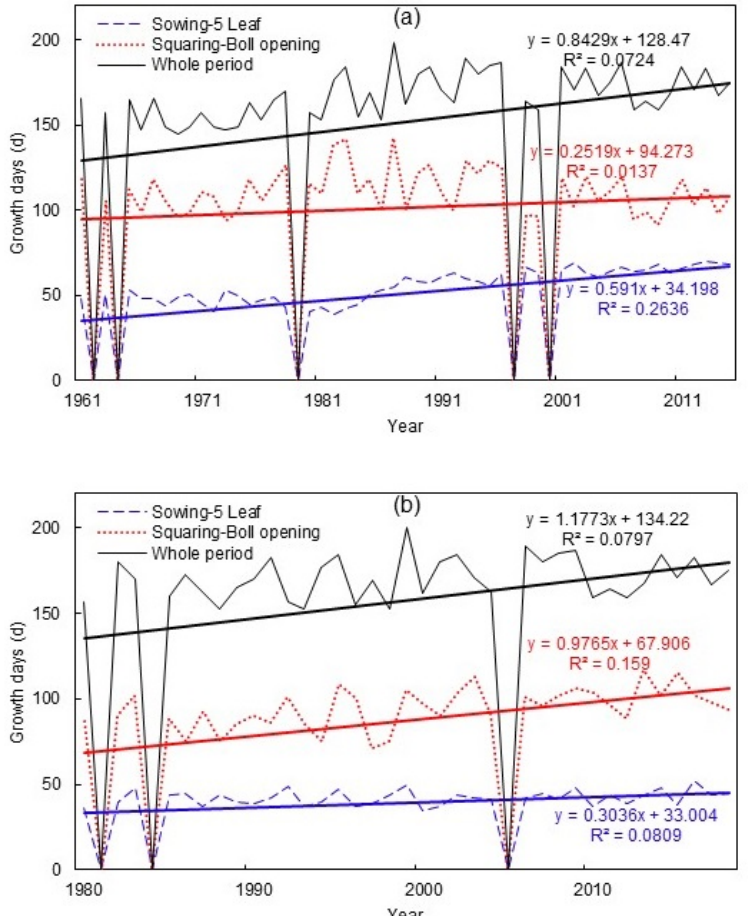
Figure 3. Simulated rends of ( a ) three simulated phenological growth stages of cotton from 1961–2015 in Punjab. Intercept values mentioned in the figure apply to the time of (growth days) sowing-five leaf stage, squaring to boll opening, and stop maturity in the starting year 1961. The variable x in the regression equations is calculated as x = year − 1961 (where p = 0.52); ( b ) three simulated phenological growth stages of cotton from 1980–2018 in Xinjiang. Intercept values mentioned in the figure apply to the time of (growth days) sowing-five leaf stage, squaring to boll opening, and stop maturity in the starting year 1981. The variable x in the regression equations is calculated as x = year − 1981 (where p = 0.18).